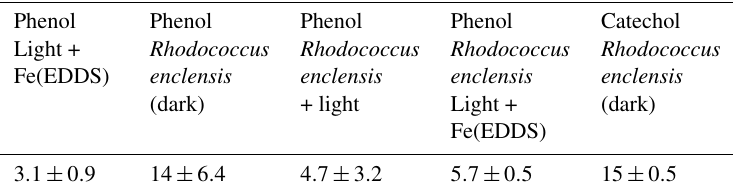
Table 1. Transformation rates (10 − 5 molL − 1 h − 1 ) of catechol and phenol under abiotic and biotic conditions. The rates were measured from three biological or chemical replicates (independent experiments), respectively. They were derived based on the steepest slopes in Fig. 2.